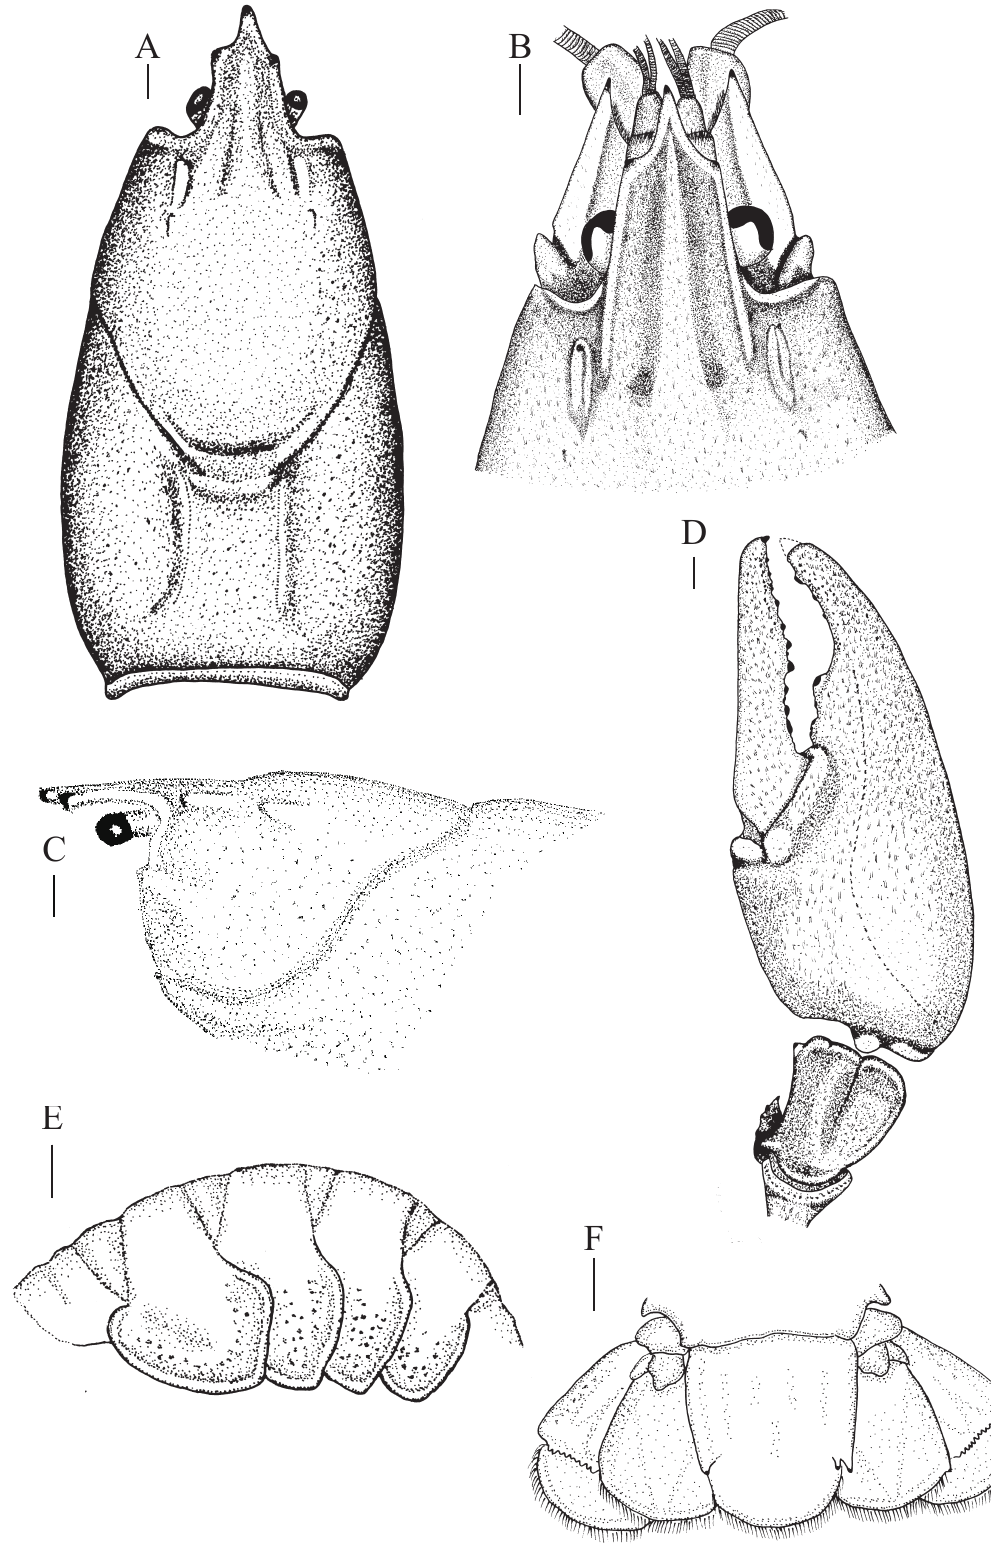
Figure 5. Pacifastacus leniusculus trowbridgii (Stimpson, 1857): all figures from syntypic male #1 (USNM 2080). A, Dorsal view of carapace; B, dorsal view of rostrum; C, cephalolateral view of carapace; D, dorsal view of cheliped; E, lateral view of second to fifth pleonal somites; F, dorsal view of telson and uropods. Scale bars = 2